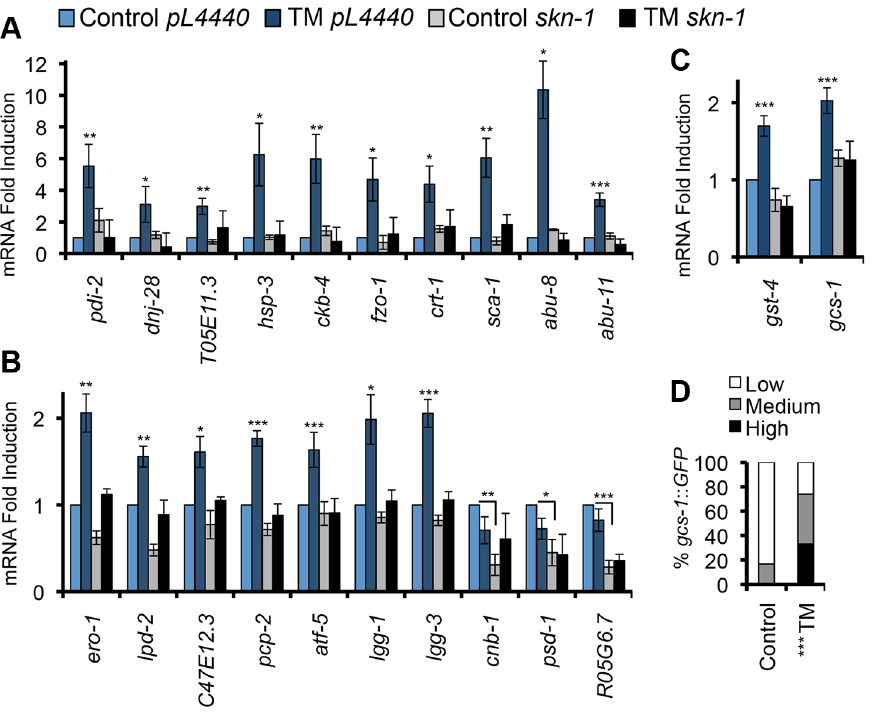
Figure 1. SKN-1 regulates diverse functions in response to ER stress. (A, B) ER stress induces skn -1-dependent activation of ER- or UPR- associated genes. qRT-PCR was performed after RNAi Control ( pL4440 in all panels) or skn-1 RNAi, and Control or 5 m g/ml TM treatment. Known or predicted functions of these genes are described in Table S1. Genes are grouped in (A) or (B) according to the extent of TM-induced activation, and plotted on different scales. All analyses of TM-regulated gene expression involved a 16 hr TM treatment, based upon a time-course experiment (Figure S1B) and published work in C. elegans [15]. Shorter time courses were chosen for other ER stress treatments (Figure 4, legend). (C) Upregulation of SKN-1-regulated oxidative stress defense genes in response to TM. Error bars represent SEM, * p # .05, ** p # .01, *** p # .001, relative to pL4440 Control. All qRT-PCR p-values were calculated as one or two-sided t-test as appropriate with n $ 3. (D) Activation of the gcs-1 :: GFP transgene in the intestine, with GFP expression scored as High, Medium, or Low. *** p , .0001 chi 2 method. See Experimental Procedures for scoring method. See also Figure S1 and Table S1.